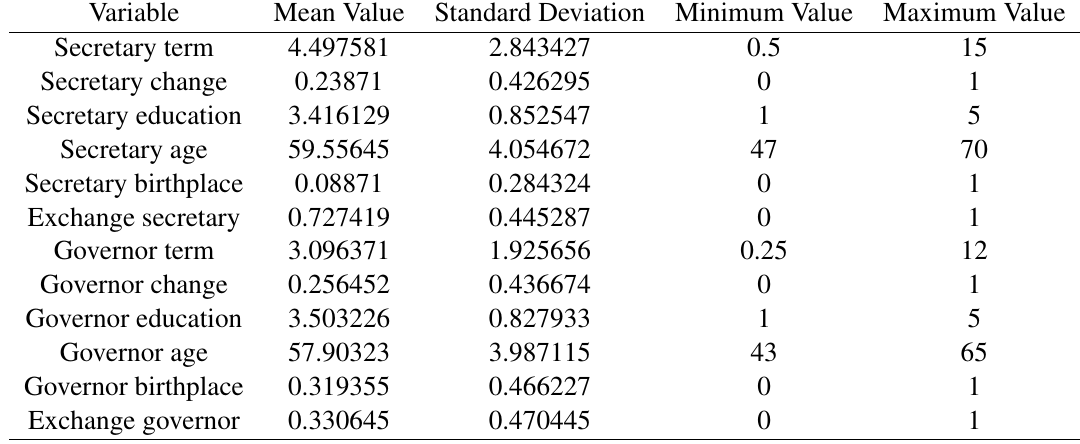
Table 3 Descriptive statistics for personal characteristics of